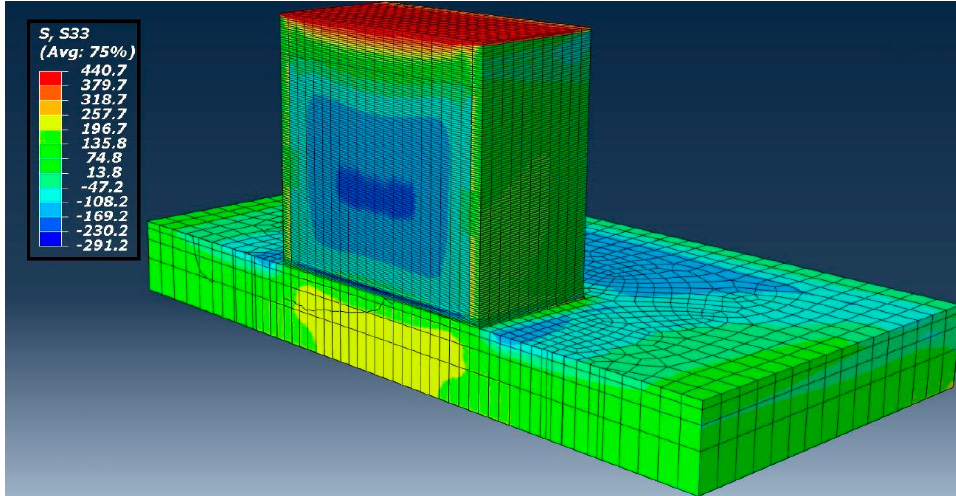
Figure 18. Residual stress of the Z component in the sliced plane.